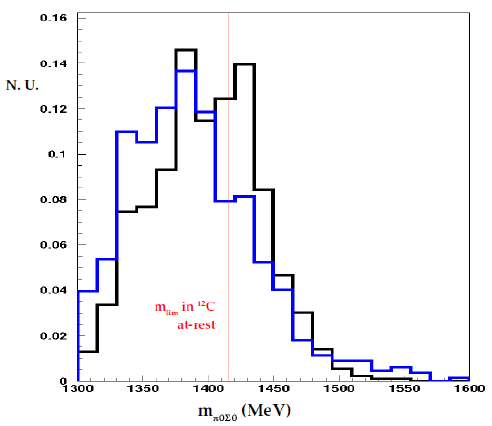
Figure 1. (Colour online.) m Σ 0 invariant mass distribution from K − captures in the KLOE DC wall π 0 (black curve) and pure carbon graphite target (blue